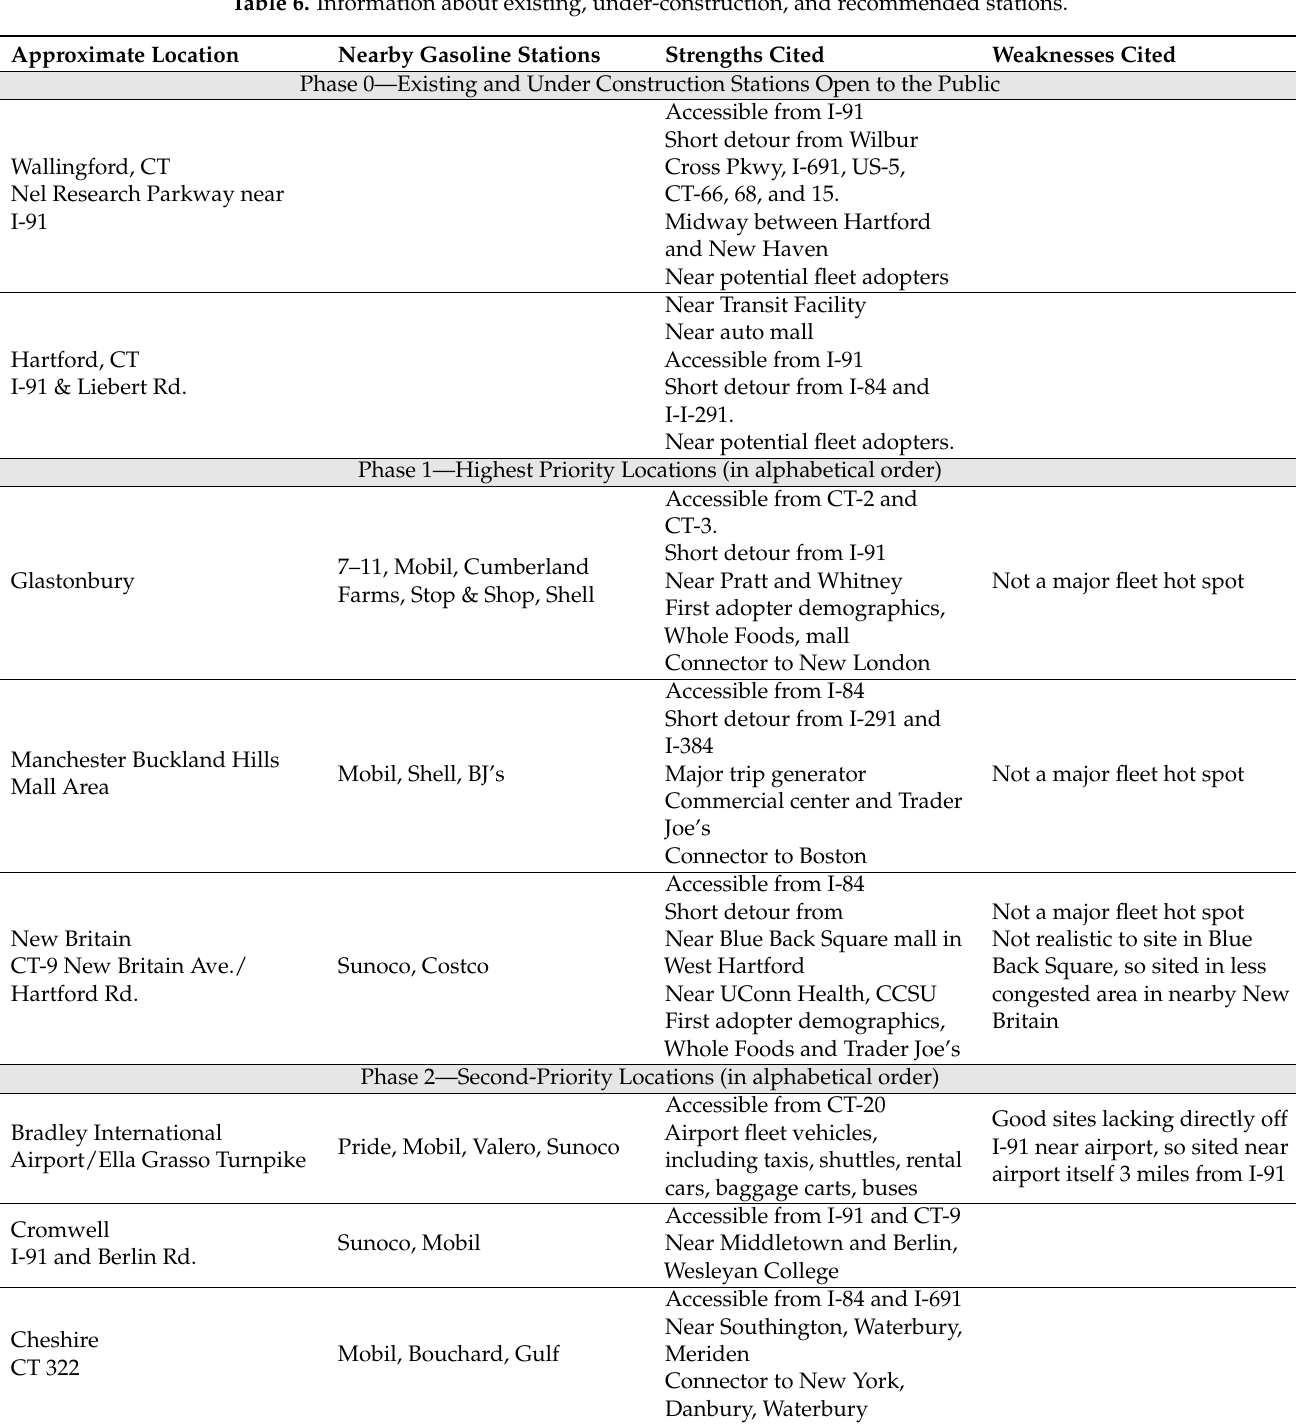
Table 6. Information about existing, under-construction, and recommended